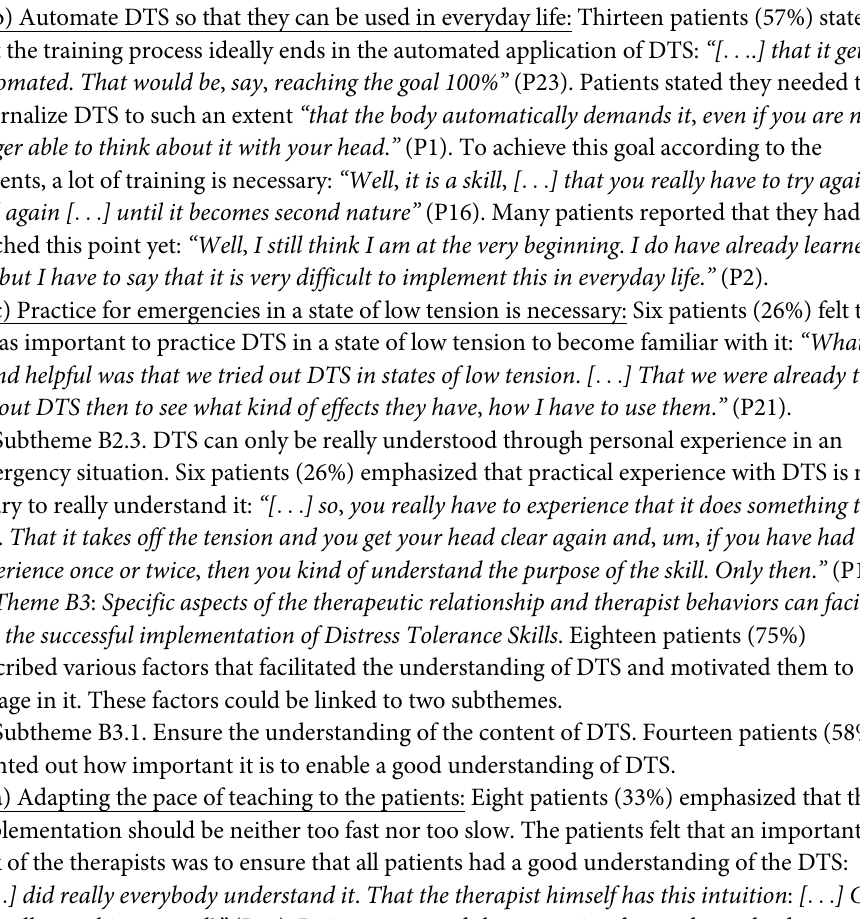
Theme B2 : You have to practice Distress Tolerance Skills . Twenty-two patients (96%)